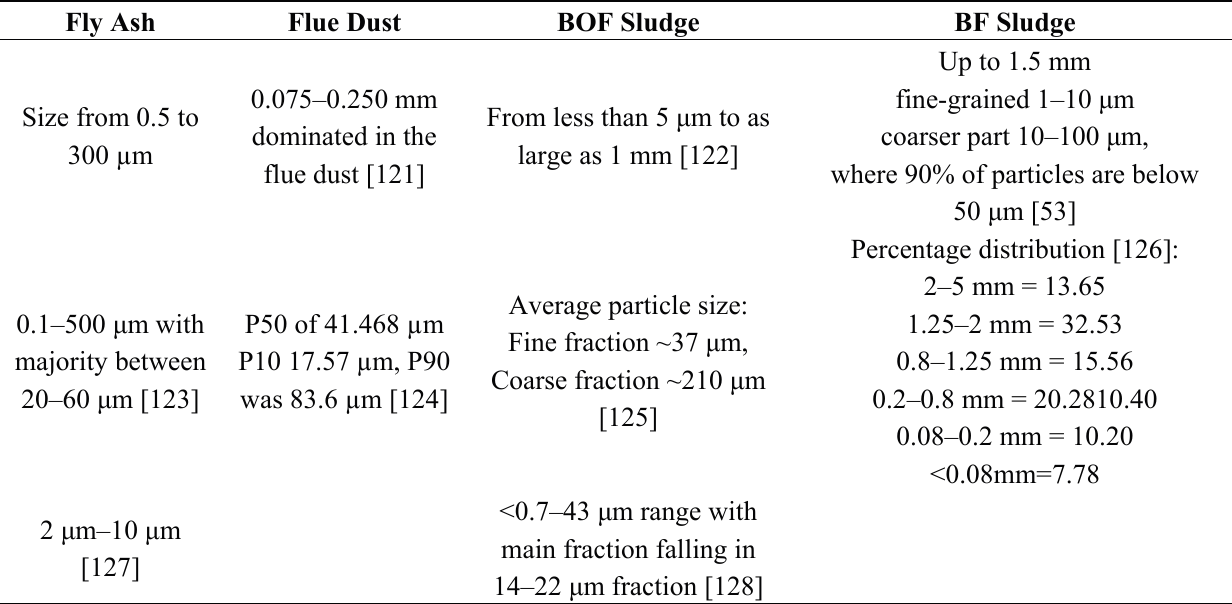
Table 7. Typical particle size distribution of industrial waste